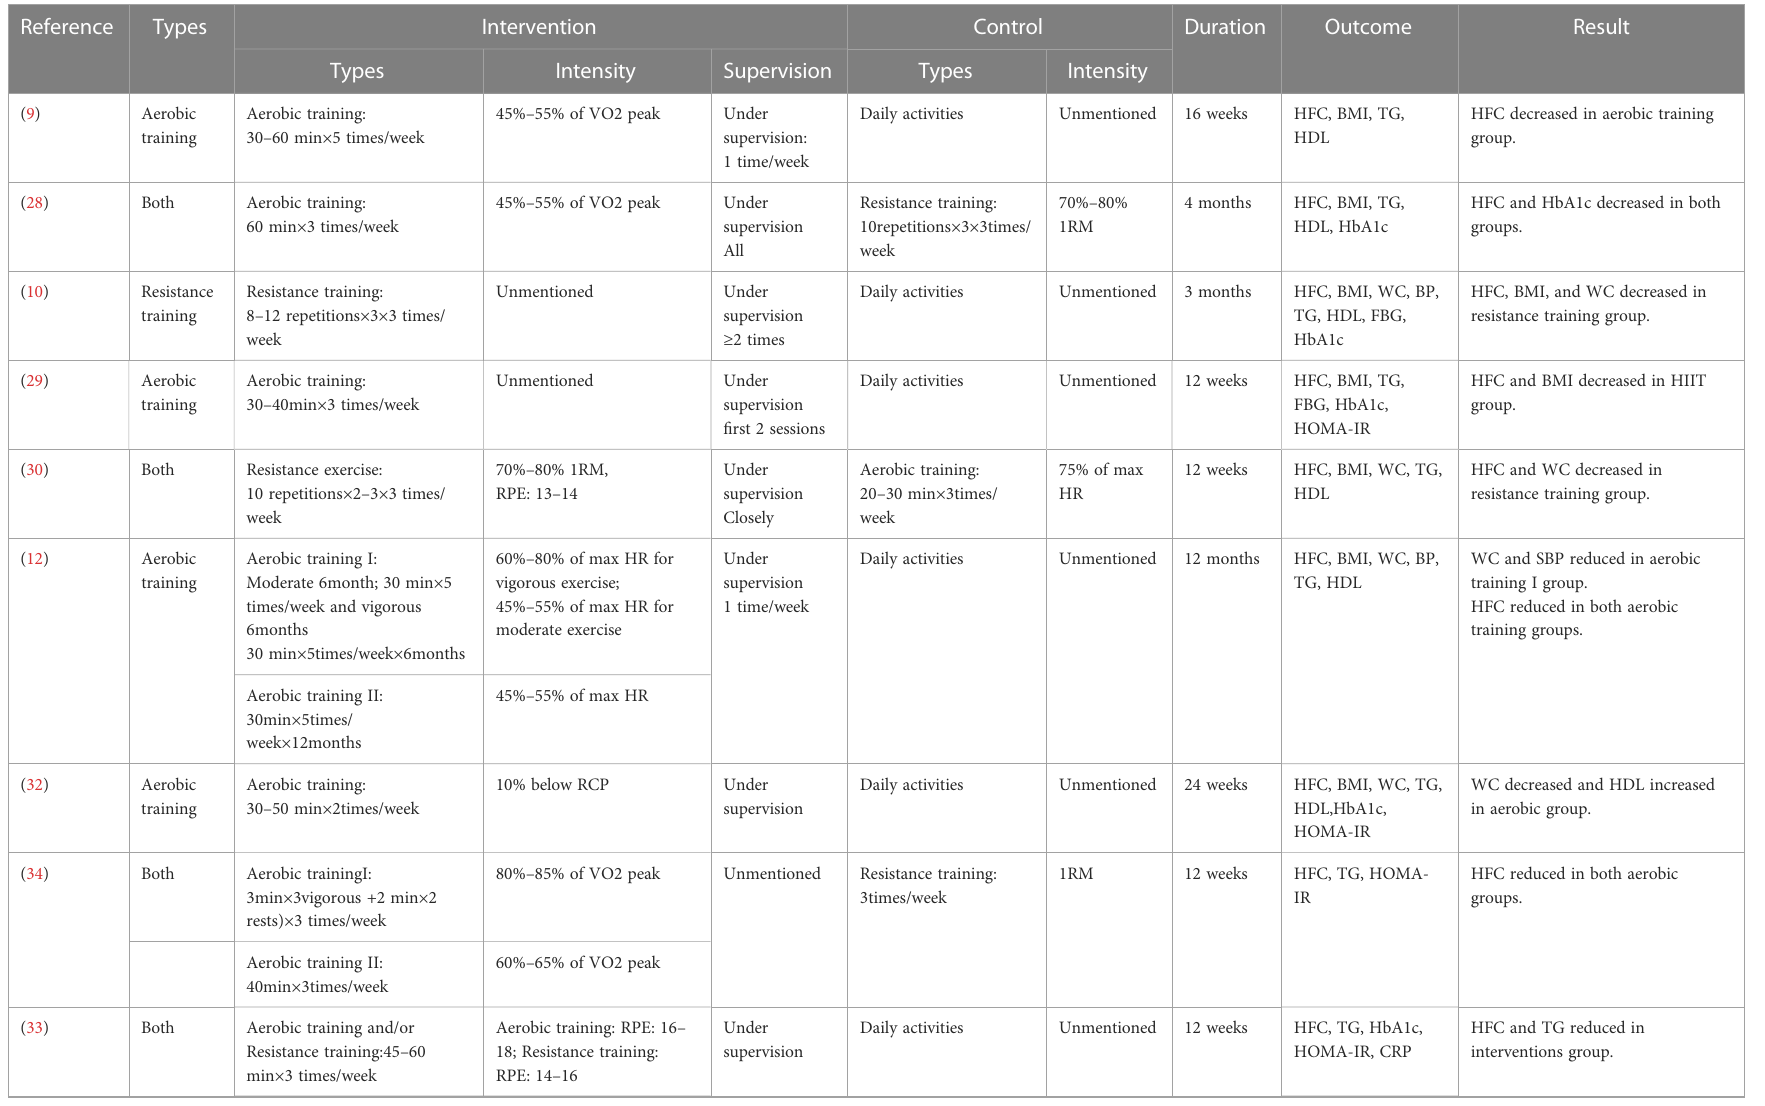
TABLE 4 Exercise